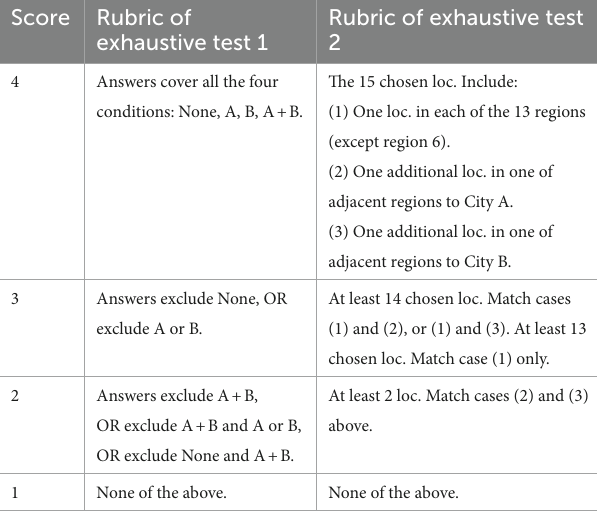
TABLE 3 Scoring rubrics of the exhaustive tests 1 and